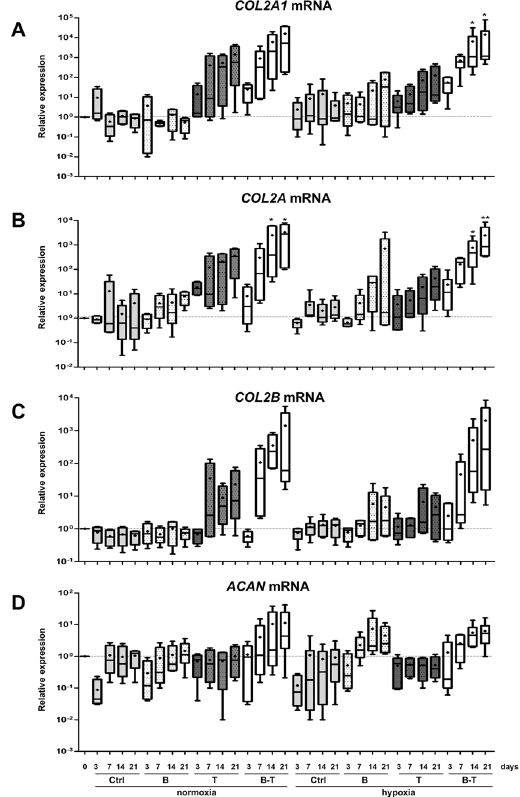
Figure 3. Effects of oxygen tension, BMP-2 and/or TGF- β 1 on the mRNA levels of specific cartilage markers. hBM-MSCs were cultured in type I collagen sponges for 3, 7, 14, and 21 days under normoxia or hypoxia, in the absence (Ctrl), or presence of 50 ng/mL BMP-2 (B), 10 ng/mL TGF- β 1 (T), or both (B-T). The steady-state mRNA levels for type II collagen were measured using real time RT-PCR with primers or probe specific for type IIA collagen ( COL2A mRNA) ( B ), type IIB collagen ( COL2B mRNA) ( C ), or the total amount of type IIA and IIB collagen ( COL2A1 mRNA) ( A ). The levels of mRNA encoding aggrecan ( ACAN mRNA) were also evaluated with specific primers ( D ). All results were normalized to RPL13a mRNA and are presented as the expression of each gene relative to that of undifferentiated hBM-MSCs at day 0. Box plots represent independent experiments performed in triplicate (n = 4). Statistically significant differences between the undifferentiated cells at day 0 and treated cells are presented and were determined using the Kruskall-Wallis test ( * P < 0.05, ** P <